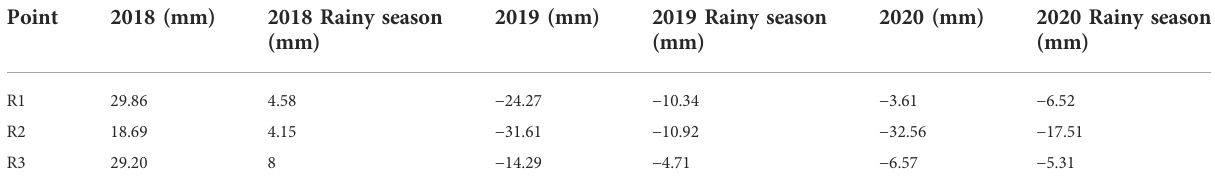
TABLE 4 Annual deformation variable and rainy season deformation variable in the right mountain. Point